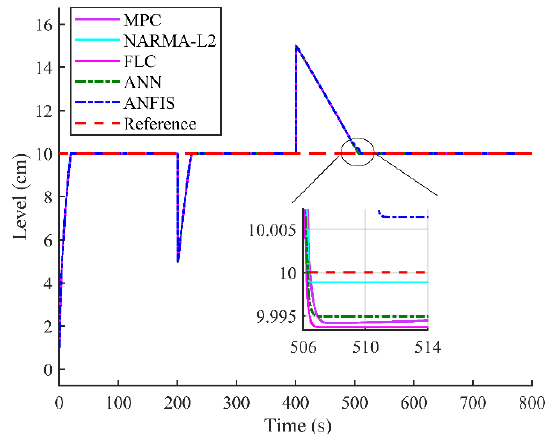
Figure 18. Result of liquid level control in the spherical tank under a transitory load disturbance.